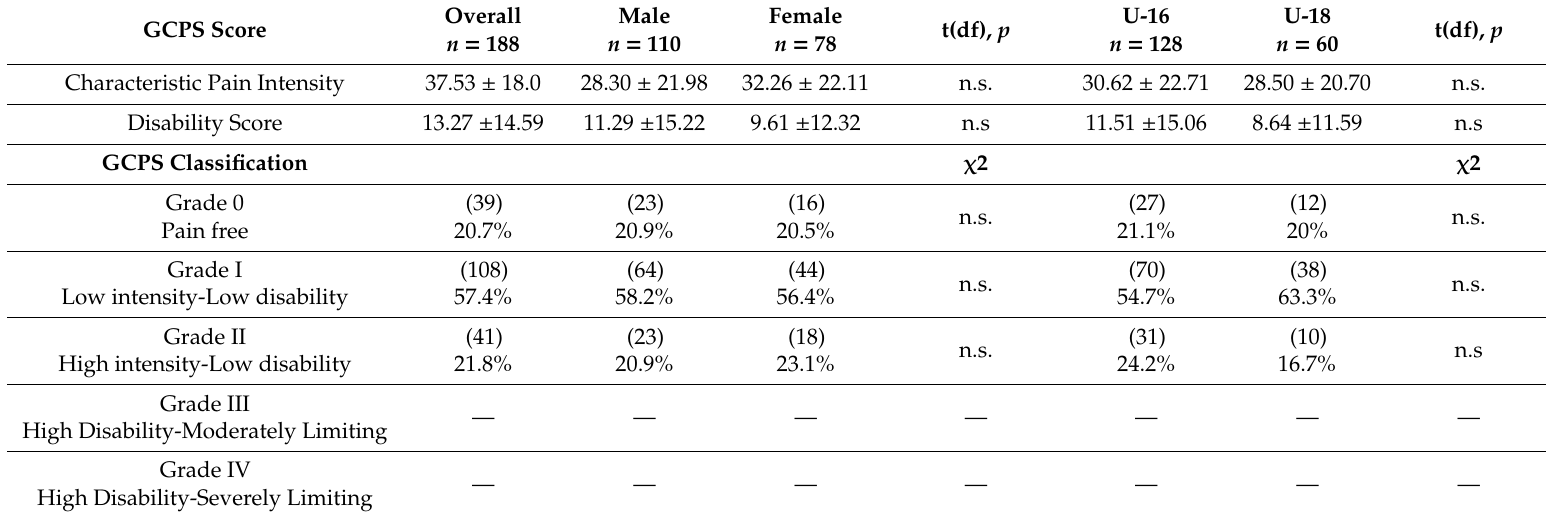
Table 2. Overview of the Graded Chronic Pain Scale (GCPS) scores and di ff erences between sexes and categories. GCPS Score